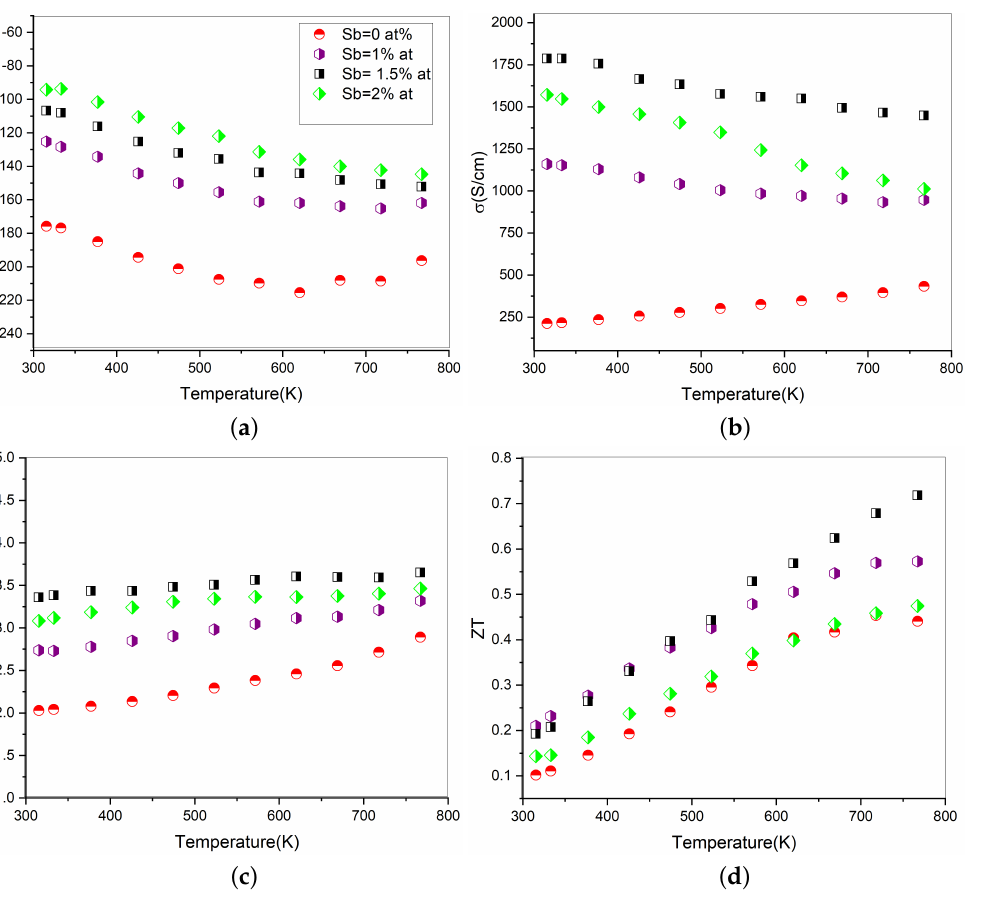
Figure 7. ( a ) Seebeck Coefficient, ( b ) Electrical conductivity, ( c ) Thermal conductivity, and ( d ) Figure of merit of Sb-doped Ti 0.4 Hf 0.6 NiSn